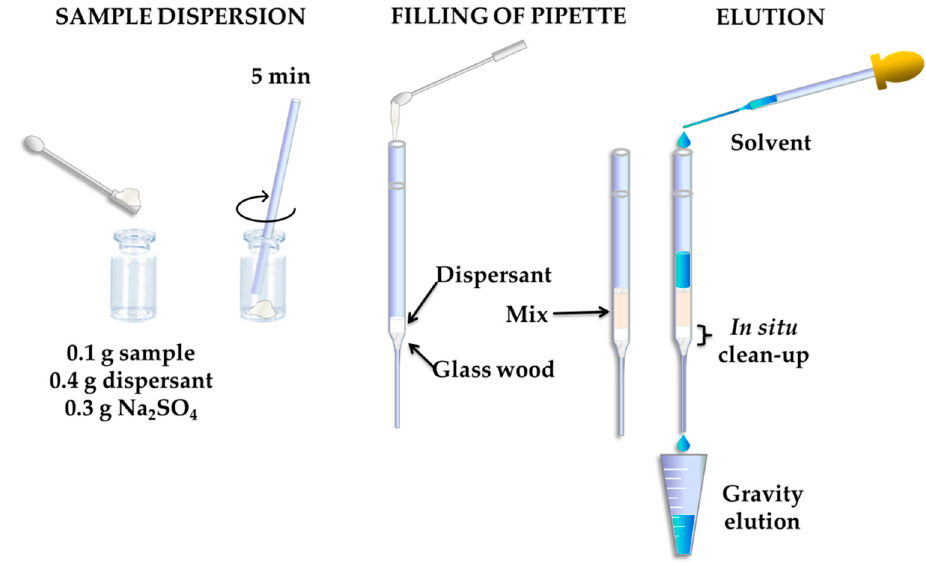
Figure 3. Miniaturized matrix solid-phase dispersion (MSPD) procedure.